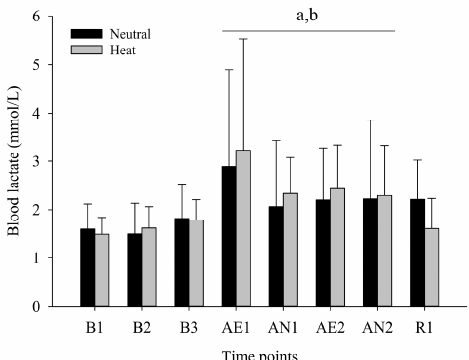
Figure 4. Blood lactate concentration in thermoneutral and heat conditions. B1, baseline; B2, second baseline; B3, third baseline, AE1, first walking; AN1, first lifting; AE2; second walking; AN2, second lifting; R1, recovery Values are mean ± standard deviation ( n = 10). a p ≤ 0.05 versus B1; b p ≤ 0.05 versus B2.